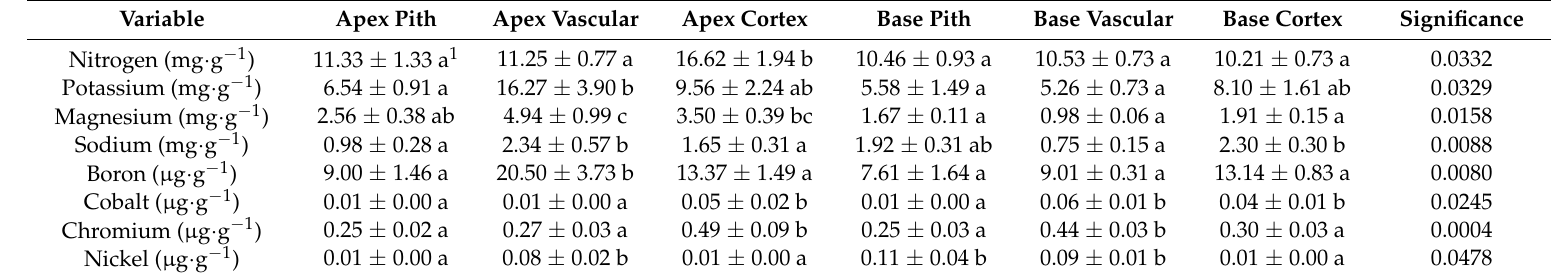
Table 2. The influence of axial and radial locations within Cycas micronesica stems on various elements. Data were presented as mean ± standard error for n =